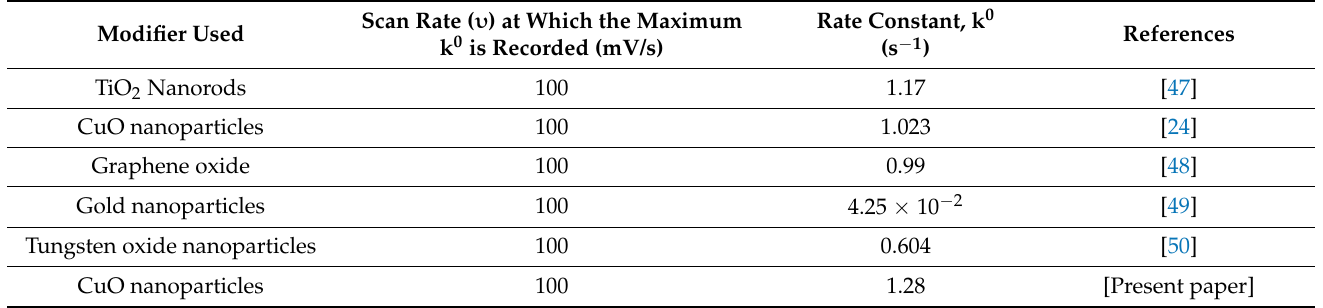
Table 4. The maximum rate constant K 0 values reported by various researchers for DA using different